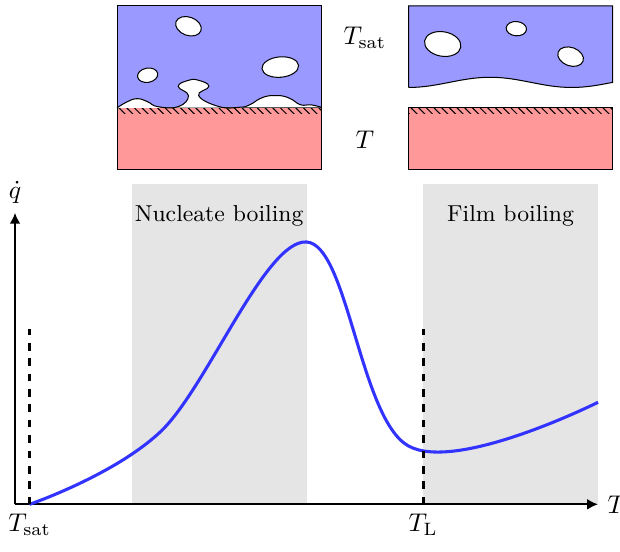
Figure 3. Illustration of a typical boiling curve for saturated pool boiling, i.e., the boiling heat flux ( ˙ q ) as a function of surface temperature ( T ). When T > T sat , the surface is considered superheated, T sat is called the surface superheat . At moderate surface superheat, we are in and the difference T − the conventional nucleate boiling regime . However, once the surface superheat becomes larger, there is a transition into a film-boiling regime , which comes with a dramatic drop in heat flux due to the formation of a continuous vapor film. The lower end of the film-boiling regime is the Leidenfrost temperature ( T L ), and crossing this from right to left is called film-boiling